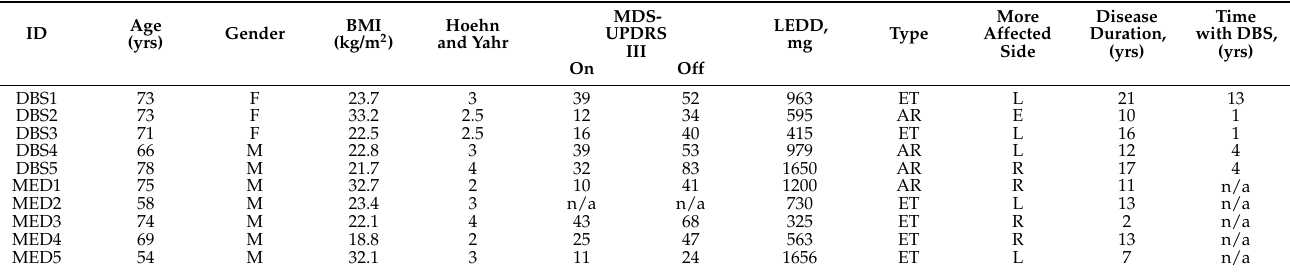
Table 1. Baseline characteristics of the Parkinson’s